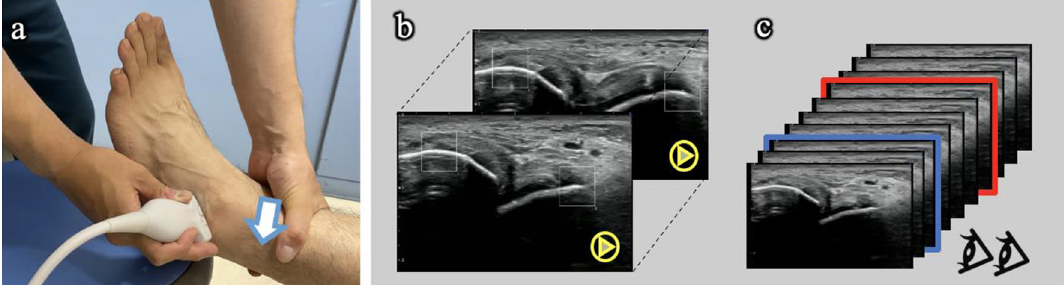
Figure 3. Sonographic data collection and measurement methods. ( a ) Reverse anterior drawer test from non-stress to loading conditions of the tibia posterior (arrow), viewed along the ATFL long axis. ( b ) ALMS; Sonographic video with one amplitude of joint motion cut/selected offline, followed by attachment of the regions of interest (ROI)s to two points on top of the talofibular joint to detect the trajectory. ( c ) Manual measurement; The two testers measure the joint distance individually by converting static images and judging minimal (blue) and maximal (red) distances. ALMS automated length measurement system, ATFL anterior talofibular